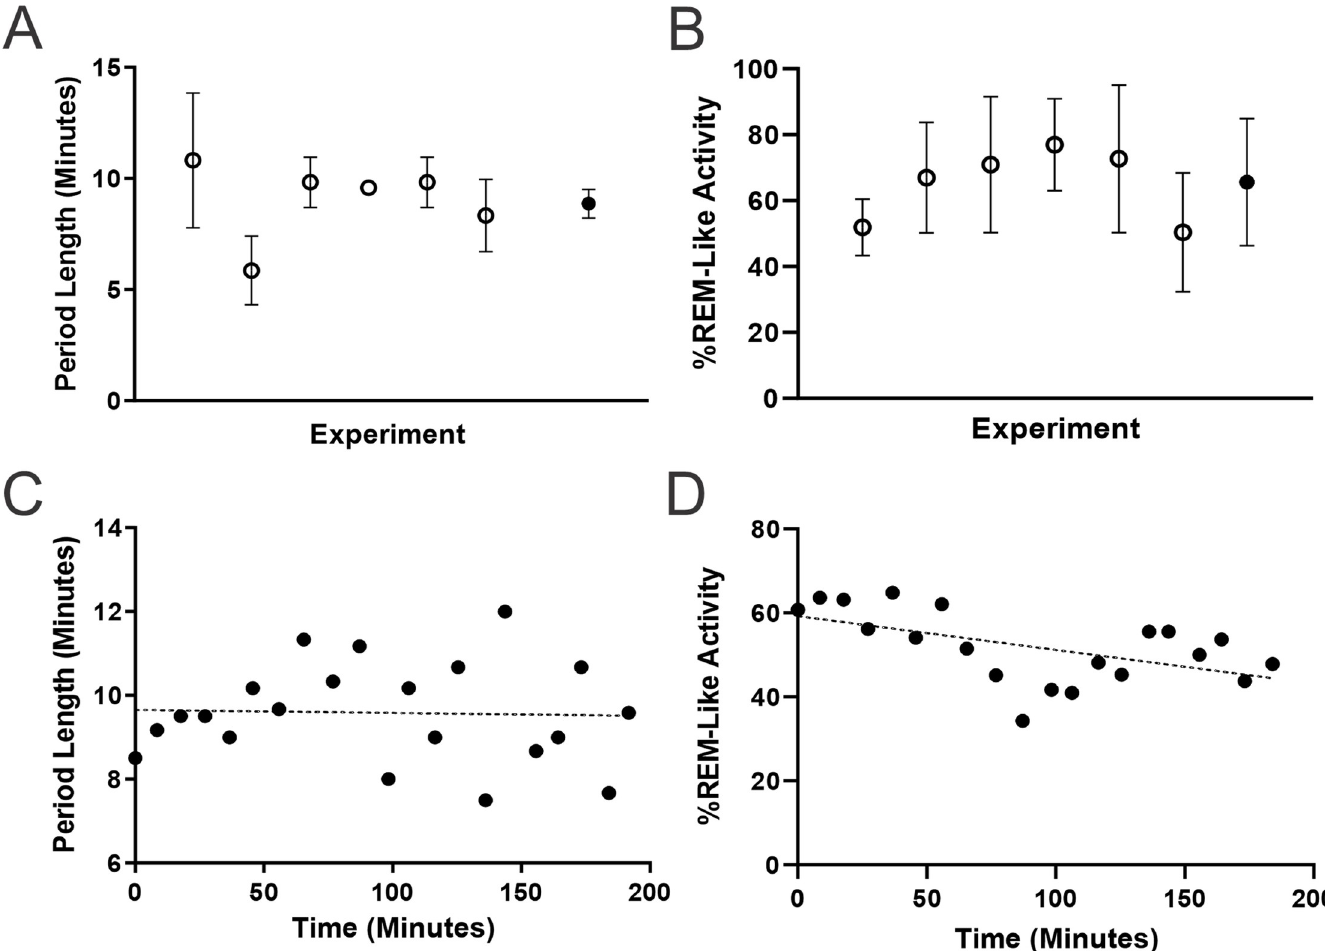
Fig 3. Stability of the spontaneous cyclic alternations in urethane anesthesia. A) The average period length (hollow circles) of individual experiments ranging in time from 110–250 minutes. Overall average period length (8.87 ± 0.64 minutes) (solid circle) for all experiments. B) Percentage of REM-like activity relative to total period length for individual experiments (hollow circle) and overall experiments (65.6 ± 0.02% REM-Like activity) (solid circle). C) Scatter plot showing period length as a function of time for a single experiment lasting 200 minutes. Linear regression line is shown in red and is not significantly different from zero (p = 0.8757), indicating the period length did not change throughout the experiment. Only 1 experiment had slopes significantly different from zero. D) Scatter plot of the percentage of REM- like activity relative to total period length for a single experiment. In this experiment, slope was significantly different than zero (R squared = 0.2953, p = 0.0133), however, this is the only experiment in which the percentage varied significantly with